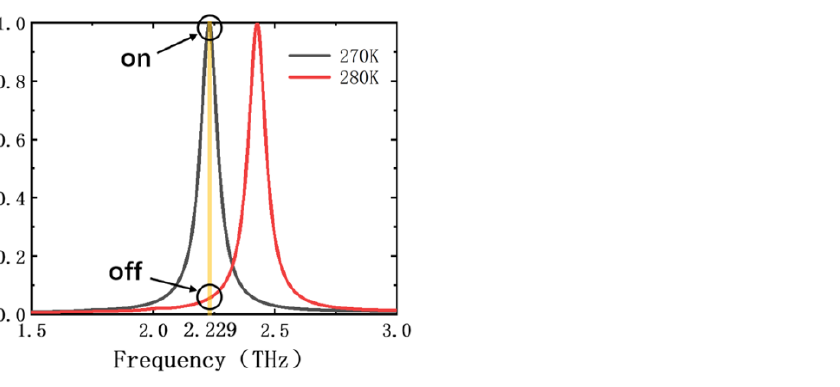
Figure 10. Absorption spectra of PMMA when external temperatures are 270 K and 280 K.